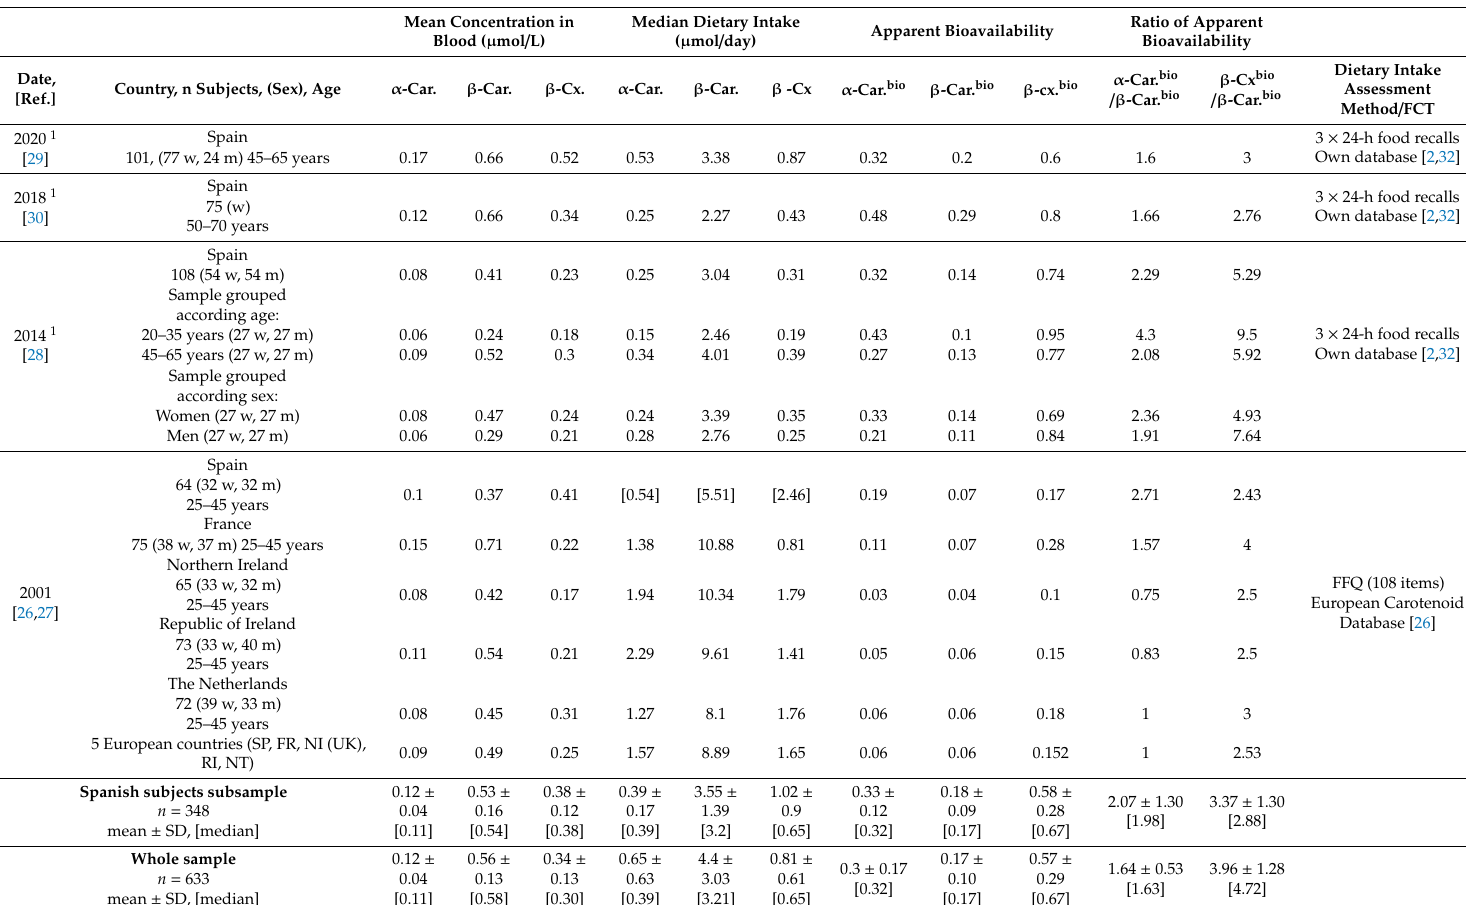
Table 1. Dietary intakes (median) and serum concentrations (mean) of α -carotene ( α -car.), β -carotene ( β -car.) and β -cryptoxanthin ( β -cx) in Spanish and other European normolipemic subjects (20–70